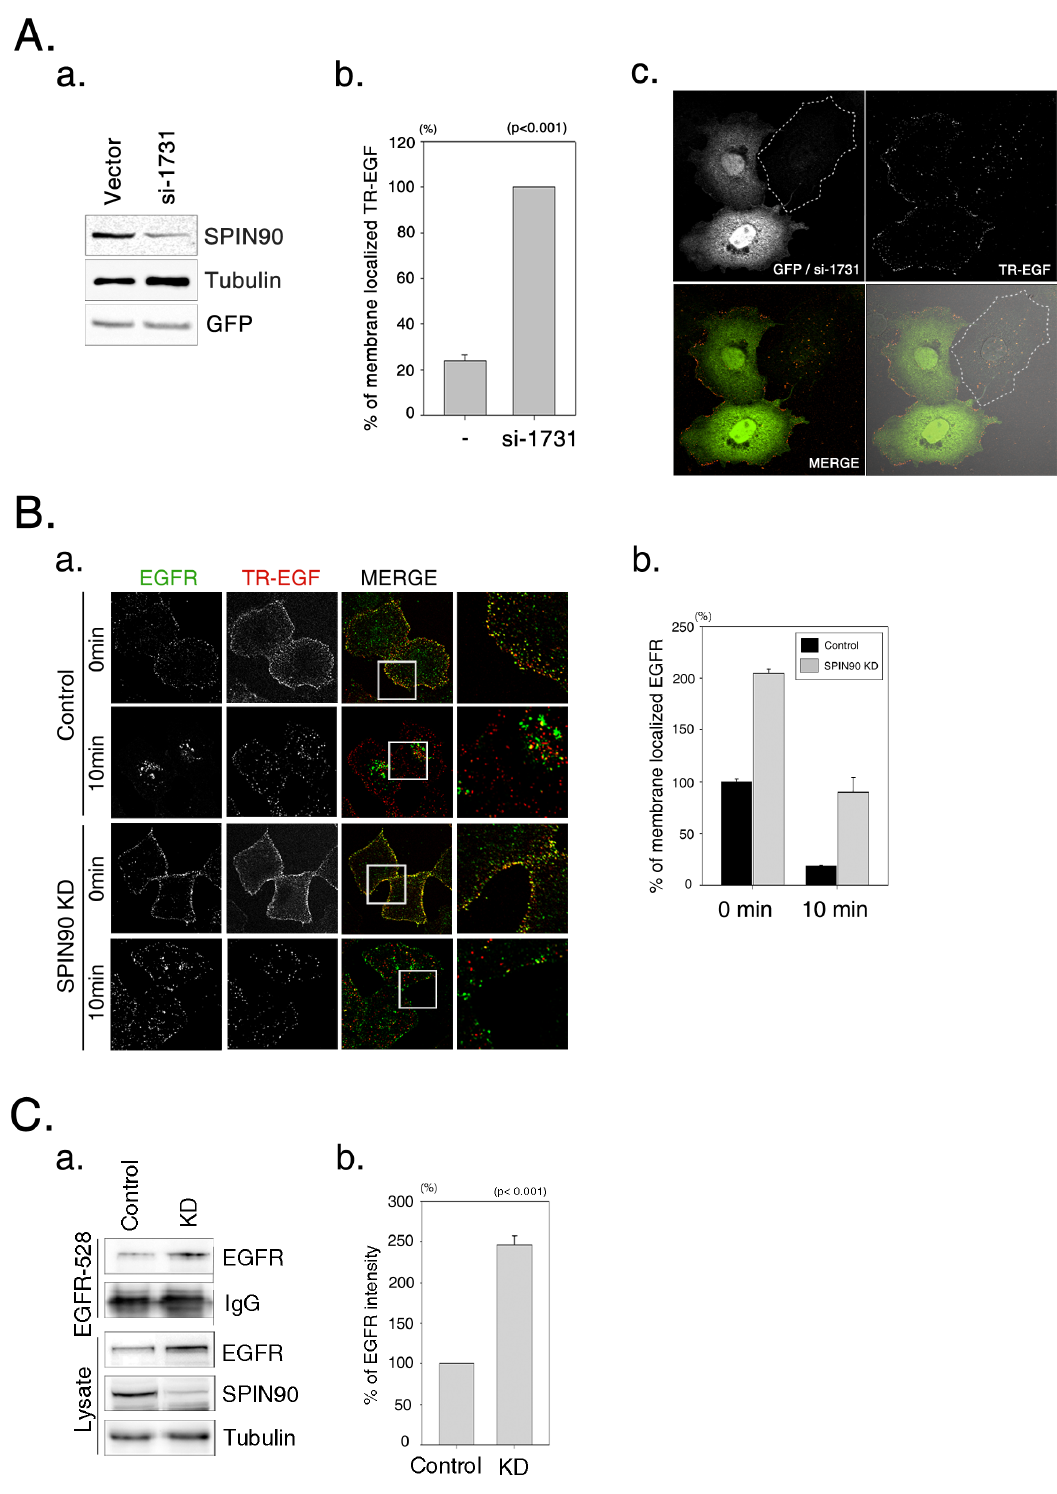
Figure 2. SPIN90 knockdown increases the levels of surface EGFR. A. HeLa cells were transiently transfected with either siRNA-hH1zeo-G2 vector or siRNA-hH1zeo-G2-SPIN90 1731 (si-1731) for knockdown of SPIN90. ( a ) SPIN90 knockdown was verified by immunoblotting using an anti- SPIN90 antibody. ( b ) Graphs indicate the levels of TR-EGF localized at membrane in si-1731 transfected cells and non-transfected cells. ( c ) siRNA- hHazeo-G2-SPIN90 1731 transfected cells were visualized by green fluorescent proteins (green). An untransfected control cell is marked by a dotted line. B. (a) Control and SPIN90 knockdown (KD) HeLa cells were treated with 40 ng/ml Texas Red (TR)-EGF for 30 min at 4 u C, followed by additional incubation for 0 or 10 min. Cells were fixed and stained with polyclonal anti-EGFR antibody and FITC secondary antibody. (b) The fluorescence intensity of membrane EGFR labeled with TR-EGF was quantified using Metamorph software. C. Cells were starved for 16 h and stained with monoclonal anti-EGFR (528) antibody for 30 min at 4 u C. Cell lysates were incubated with protein A/G Sepharose beads for 2 h, and resolved using